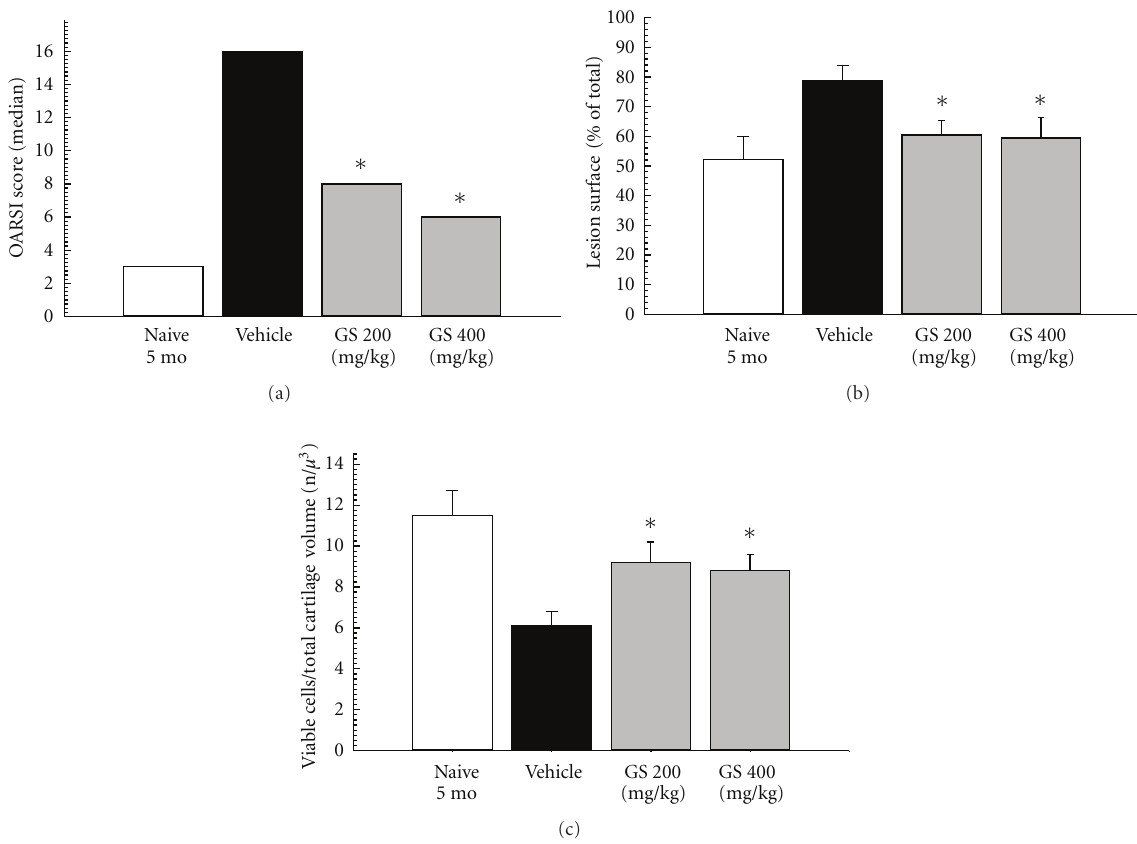
Figure 5: (a) E ff ect of subcutaneous administration of GS on OARSI score in STR/ort mice. Data are represented as median. (b) E ff ect of subcutaneous administration of GS on Lesion surface/total surface in STR/ort mice. Data are represented as mean ± SE. (c) E ff ect of subcutaneous administration of GS on n. of viable cells/total cartilage volume in STR/ort mice. Data are represented as mean ± SE. ∗ = P < 0 . 05 versus vehicle (ANOVA). The vehicle group is always statistically di ff erent from the na¨ıve 5-month-old